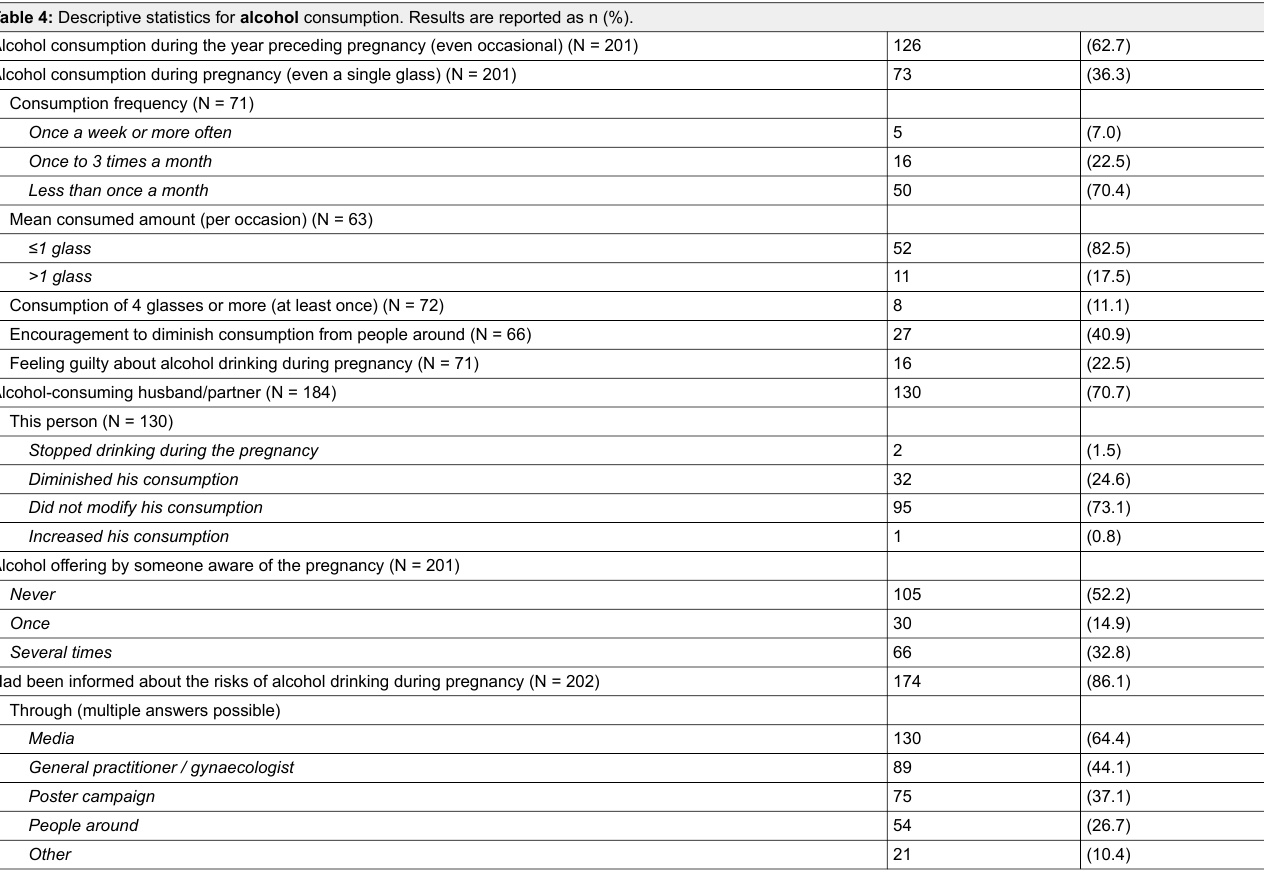
Table 4: Descriptive statistics for alcohol consumption. Results are reported as n (%). Alcohol consumption during the year preceding pregnancy (even occasional) (N =